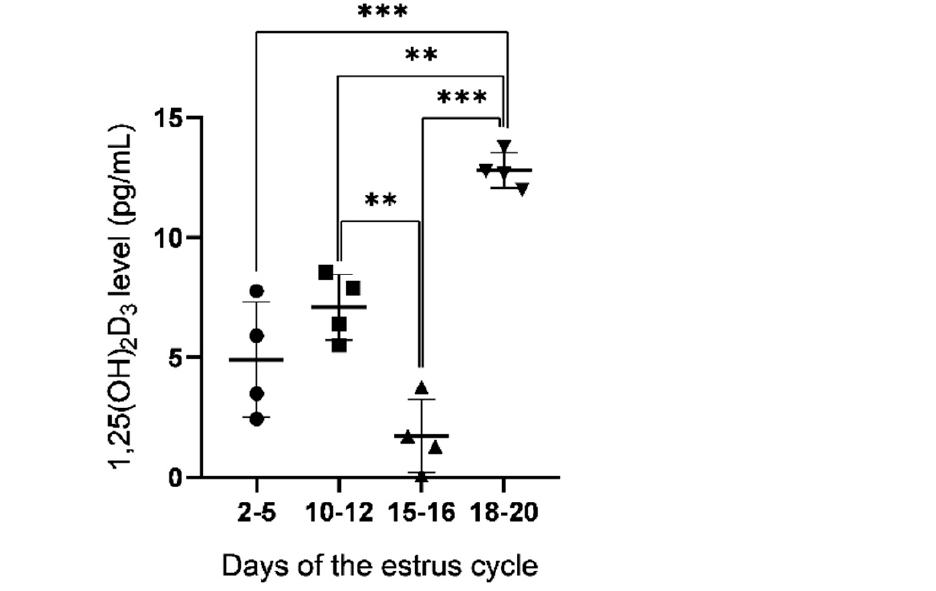
Figure 1. The concentration of 1,25(OH) 2 D 3 (mean ± SD) in uterine flushings obtained from pigs on days 2–5, 10–12, 15–16 and 18–20 of the estrous cycle. ** p < 0.01; *** p < 0.001 (one-way ANOVA followed by Tukey post hoc test). n = 4 per each group.